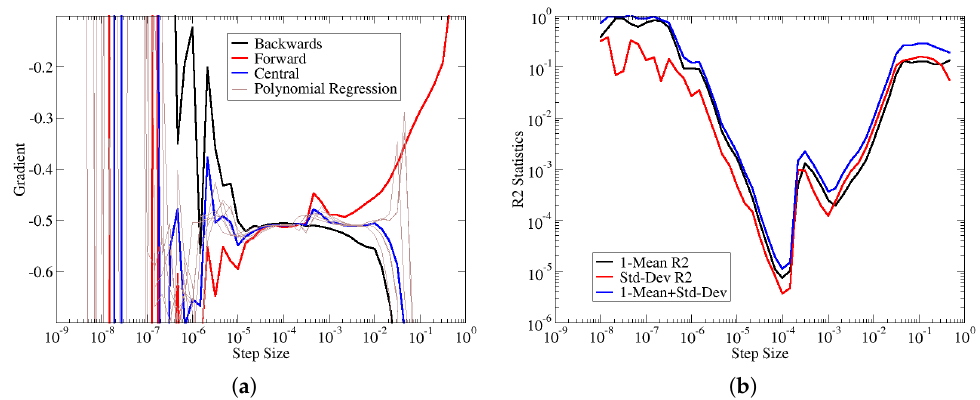
Figure 3. Examples of correspondence between gradients and coefficient of determination. The thin brown curves on the left correspond to the gradient estimates of the polynomial regression. The R 2 statistics on the right correspond to the same polynomial curve fits. For each step size, there are 9 polynomials and 9 corresponding gradients and coefficients of determination. ( a ) Blade failure gradient with respect to laminate thickness control point. ( b ) Blade failure vs. laminate thickness R 2